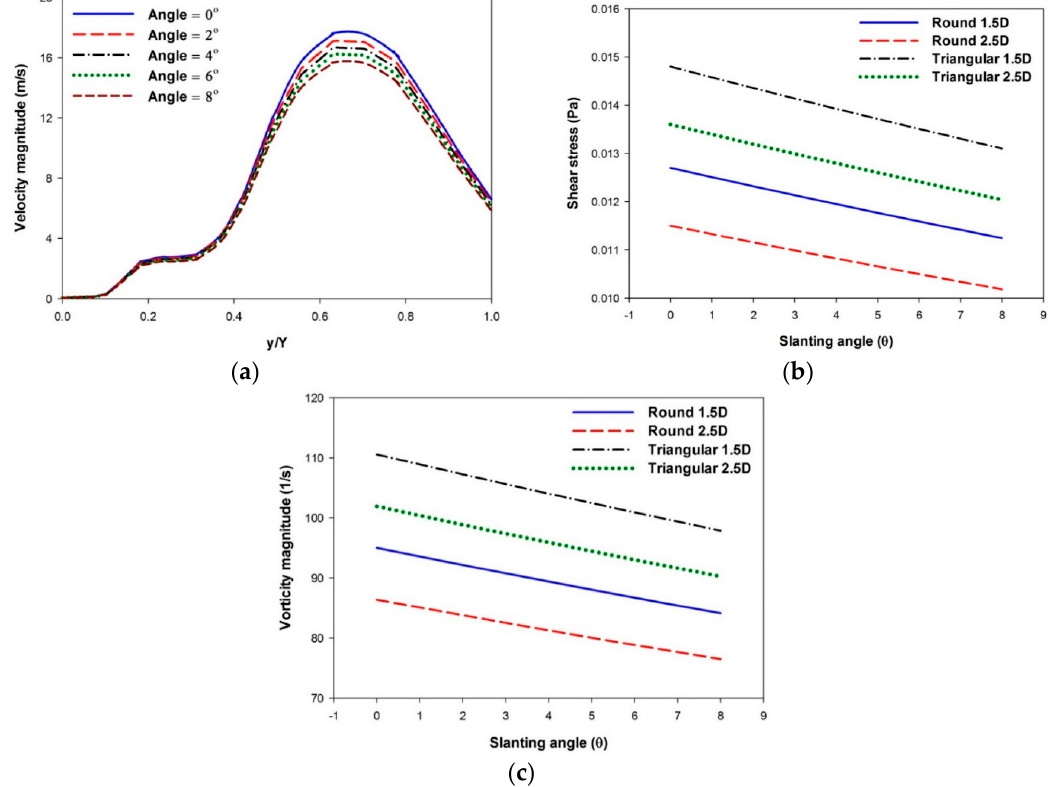
Figure 8. Effect of bed slanting angles ( θ ) on the ( a ) velocity magnitude of +4 D duct hole diameter at point 1, ( b ) shear stress with different duct hole shapes and ( c ) vorticity magnitude with different duct hole shapes at an air inlet velocity of 35 m/s.